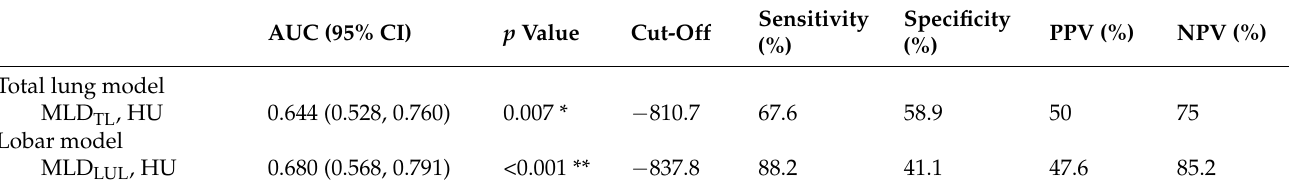
Table 5. Sensitivity, specificity, PPV and NPV with cut-off values of multiple logistic regression models.